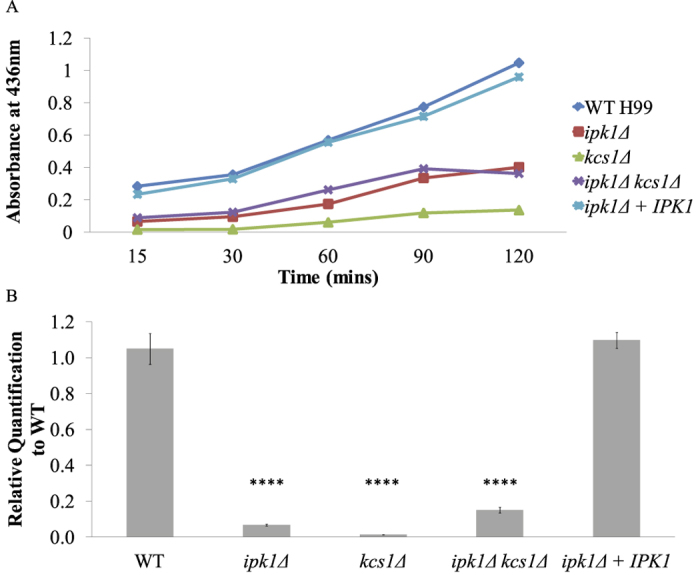
Effect of IPK gene deletion on extracellular laccase activity (A) and LAC1 gene expression (B).Strains were incubated for 3 and 6 hours at 30 °C in minimal media without glucose for gene induction and enzyme assay, respectively. (A) ABTS was then added and the amount of oxidised ABTS at each time point was measured spectrophotometrically at 436 nm. (B) LAC1 gene expression was determined by qRT-PCR with ACT1 used as the reference gene for normalization. A one-way ANOVA multiple comparisons test of all strains revealed a statistically significant difference between the 3 mutants and both WT and ipk1Δ + IPK1. (****p-value < 0.0001 and error bars represent standard deviation).